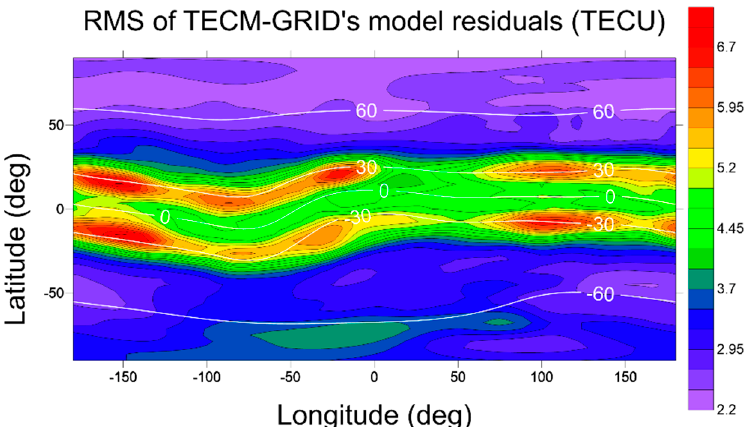
Figure 3. RMS value of model residual for TECM-GRID. ( Notes. The modified dip latitude is marked by a white line, henceforth.)